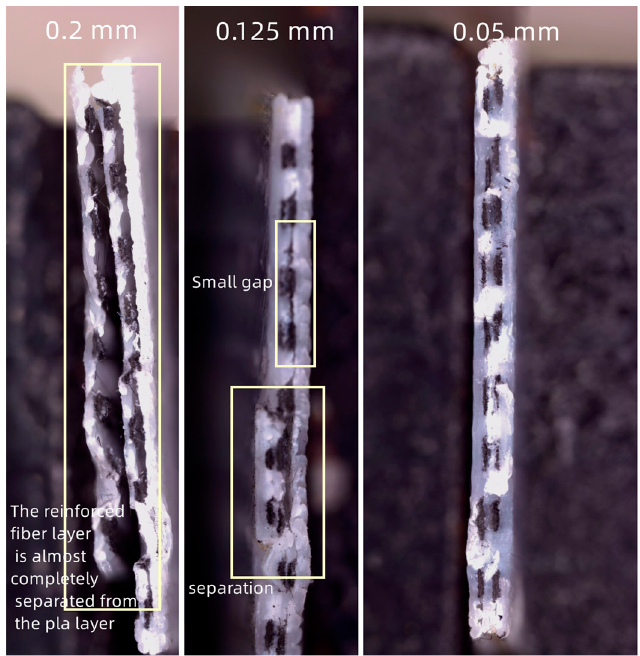
Figure 7. Interlayer micrograph of printed specimens.